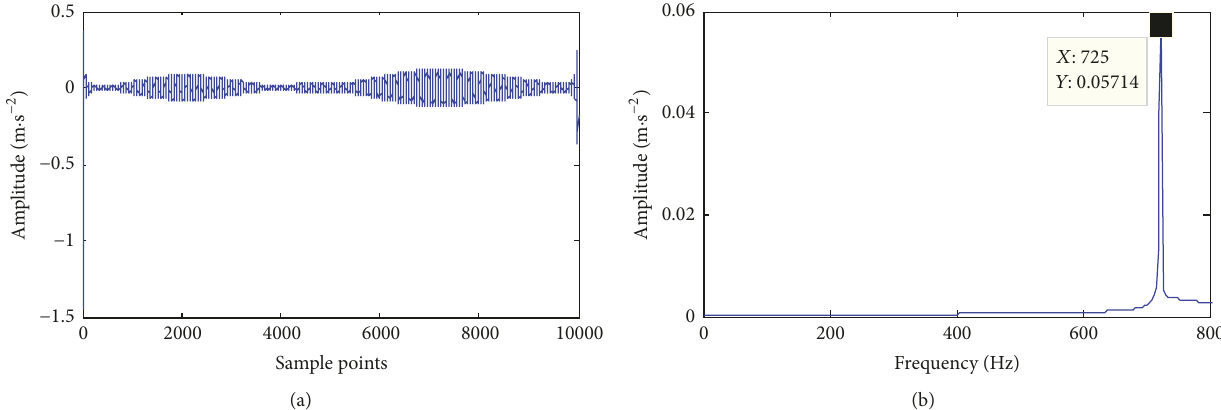
Figure 20: (a) The time domain of output signal by AMD. (b) The experimental signal results of VMD decomposition. 1900 and 1. The signal in the time and frequency